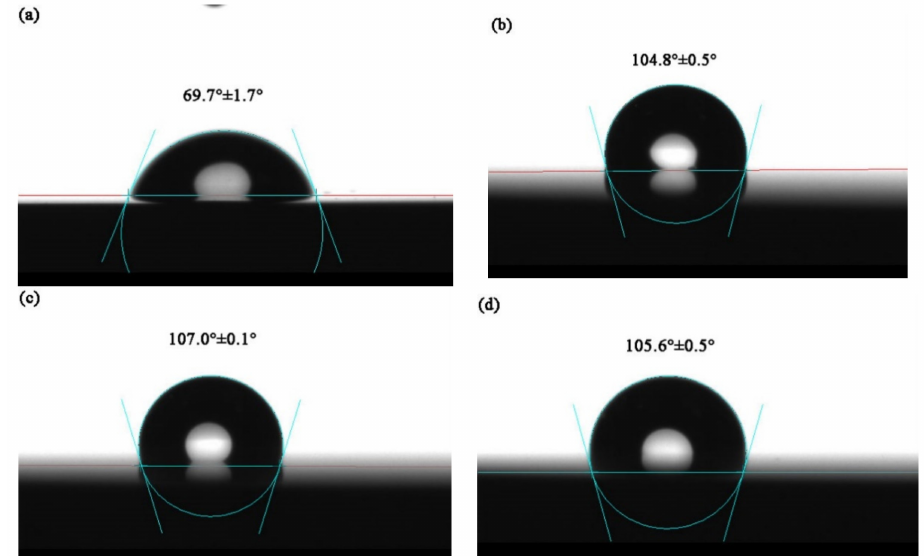
Figure 10. Water contact angle of SS316L and TiMoN coatings: ( a ) SS316L, ( b ) TiMoN-2A, ( c ) TiMoN- 4A, ( d )